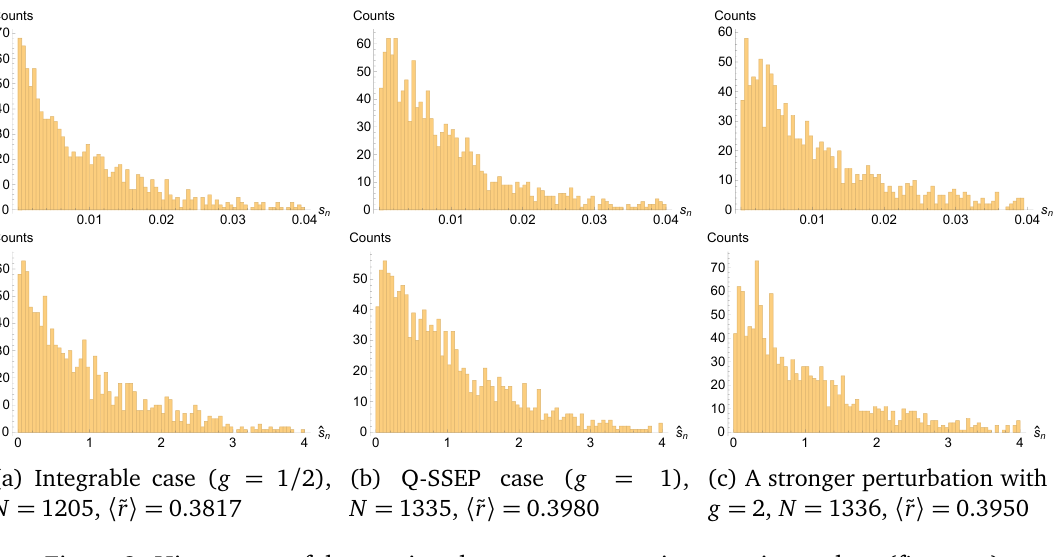
sector. The deformations are 0 (cid:80) ( P − gQ − 1 ) such that g = 1 j ; j + 1 j ; j + 1 j − C ) = ( 5,3,3 ) . The value for N provides 2 , J z , C 1 2 1 2